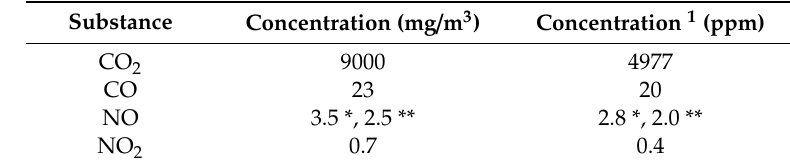
Table 2. Threshold concentrations for the selected gaseous substances in the mine air [24]. The health and safety (H&S) standard is defined as the 8-h time-weighted average concentration of the substance.